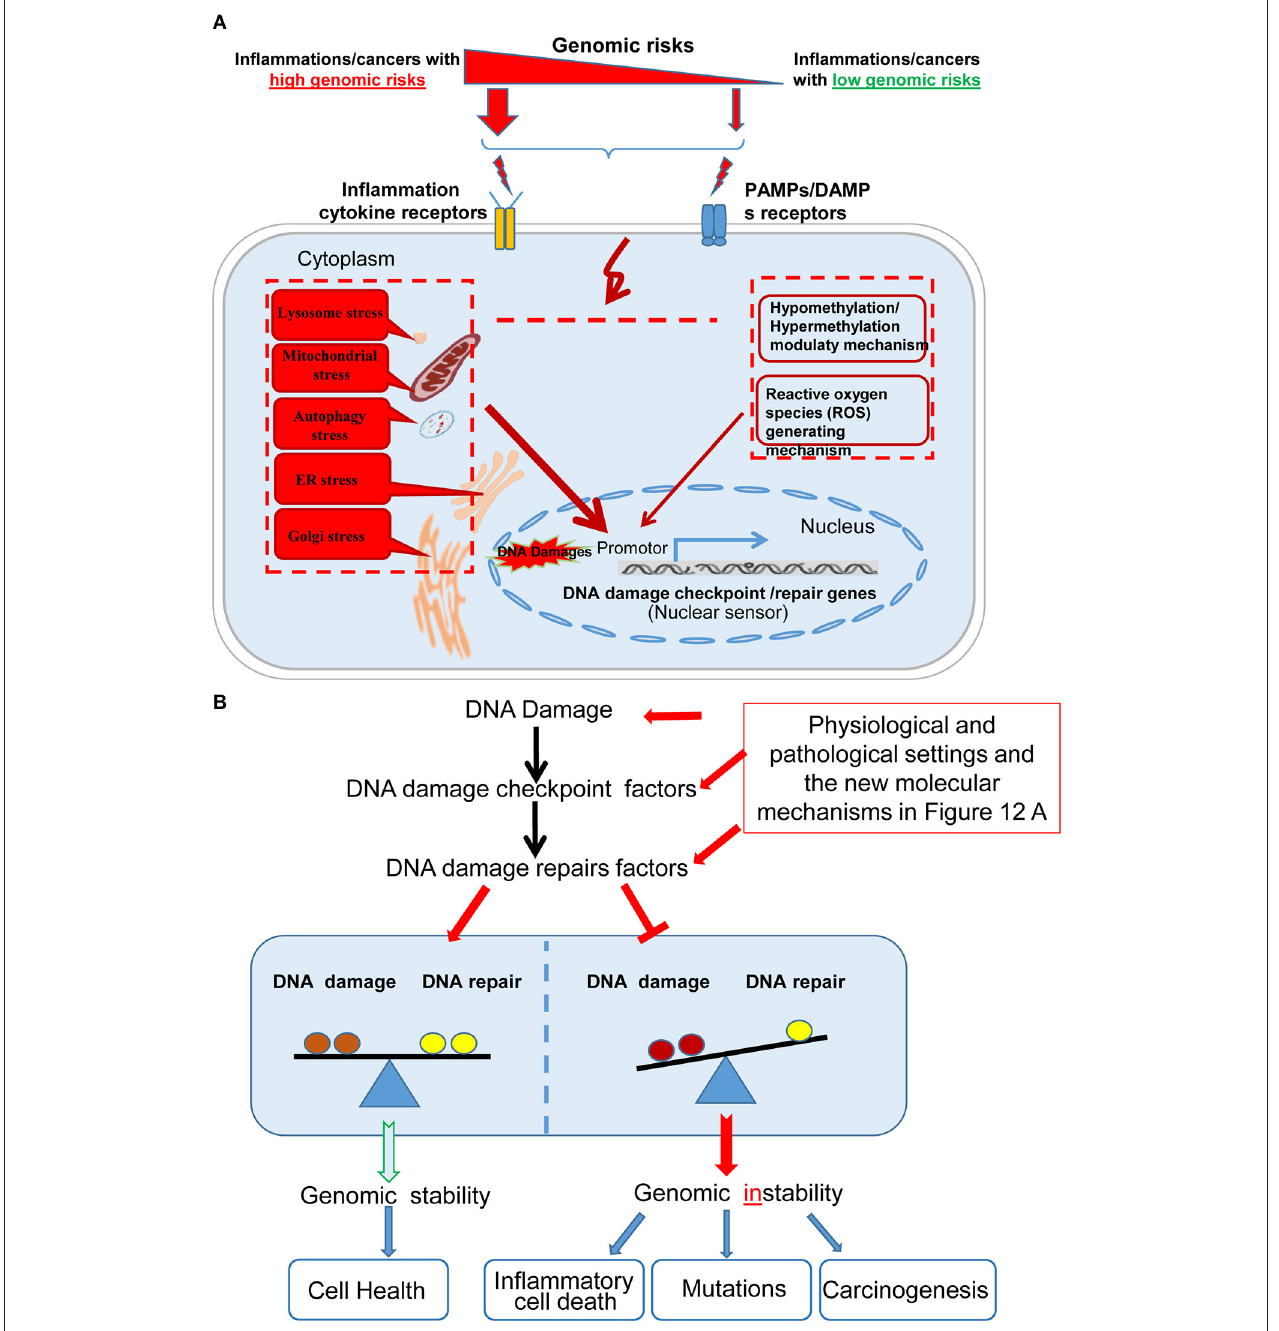
FIGURE 12 | A new working model on cellular sensor cross-talking network. (A) Our new model integrates the following new findings: First , sterile inflammatory disorders and cancers can be classified into high, medium and low genomic risk groups based on the level of modulation of DNA damage response factors. Diseases-related danger associated molecular patterns (DAMPs)/pathogen associated molecular patterns (PAMPs) bind to DAMP- and PAMP-receptors respectively, leading to subsequent activation of downstream cytokine receptors to generate intracellular organelle stresses. One possible mechanism that intracellular organelle stresses may modulate DNA damage response factor expression is by regulating the methylation status of the cells and via canonical and non-canonical inflammasomes pathways. (B) The interplay between DDCFs and DDRFs under physiological and pathological conditions lead to either the maintenance or loss of balance between DNA damage and DNA repair mechanisms. The balance between DNA damage and DNA repair lead to maintenance of genomic stability and cell health. In contrast, increased DNA damage but decreased DNA repair would result in genomic instability and subsequent inflammatory cell death, gene mutations and